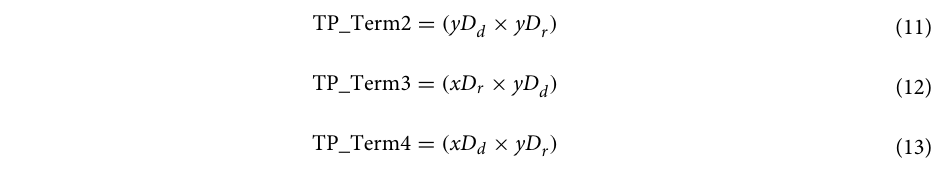
Figure 3. Schematic diagram of the proposed Baudhayan-Pythagoras triplet algorithm circuit block of the complex